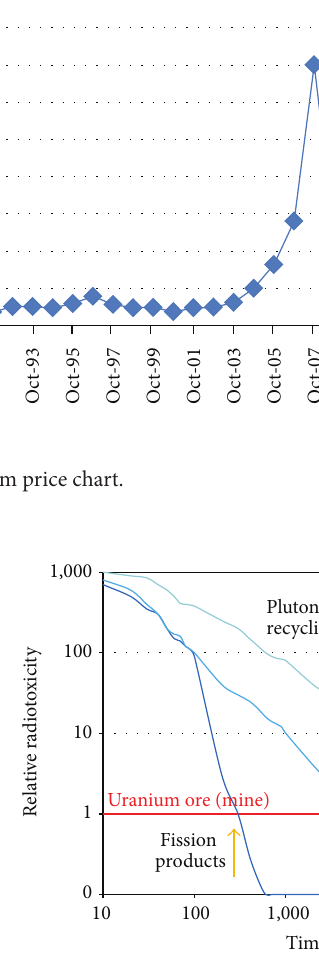
Figure 5: Radioactive decay. Source: adapted from Commissariat `a l’´energie atomique 2013